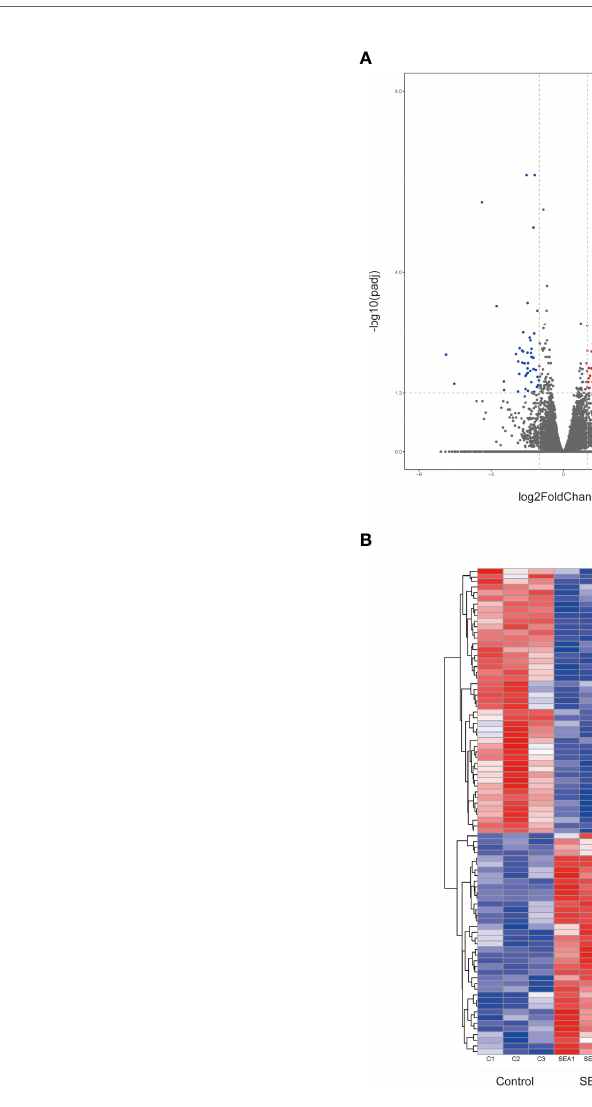
FIGURE 2 | Volcano map and hierarchical clustering heat map of DEGs. (A) (|log2Foldchange|>1, p adj < 0.05) DEG volcano distribution map; red represents upregulated transcripts; blue represents downregulated transcripts. (B) Hierarchical clustering heat map of DEGs ( n = 3) in each